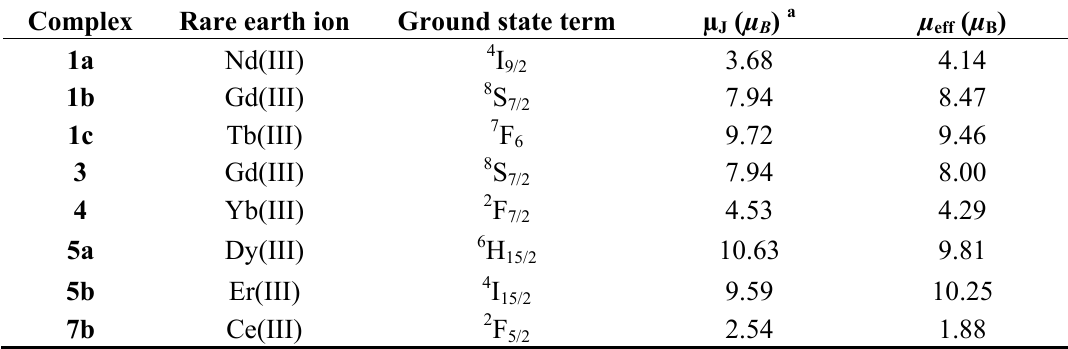
Table 2. Theoretical and observed solution magnetic